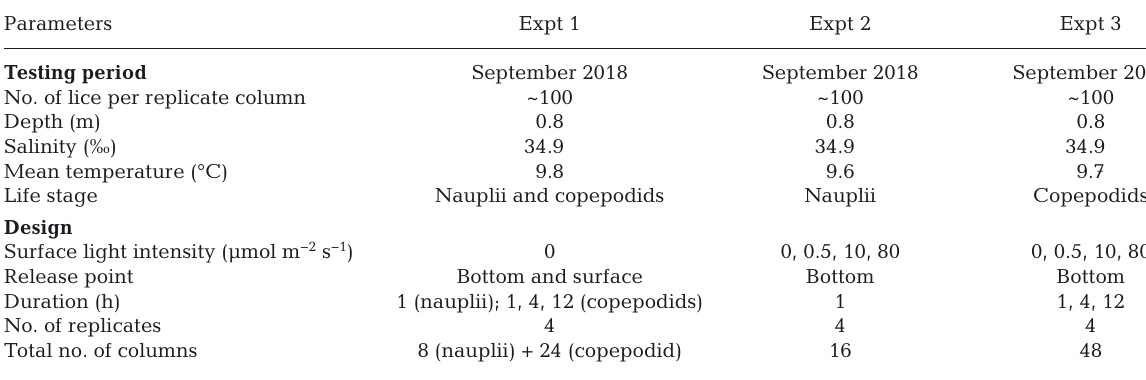
Table 1. Experimental designs and environmental parameters under which the vertical distribution of Lepeophtheirus salmonis nauplii and copepodids were tested in response to different release points, depths and light